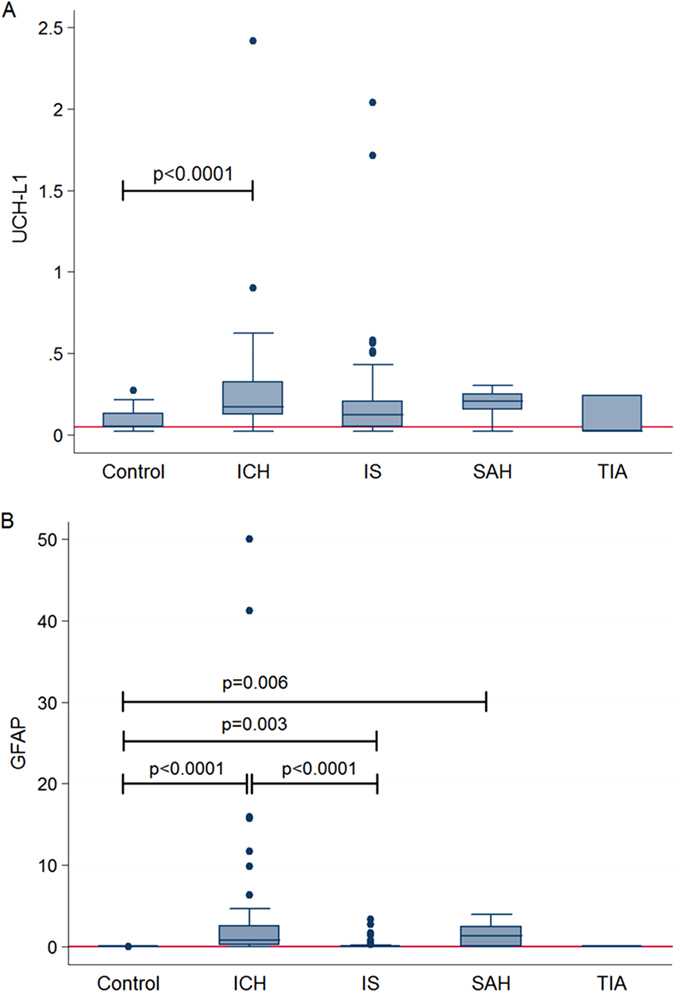
Box-and-whisker plots demonstrating UCH-L1 and GFAP concentrations within 24 hours of symptom onset.Serum UCH-L1 (A) and GFAP concentrations (B) in patients with stroke or TIA and controls. The horizontal line in each box represents the median, with the boxes representing the interquartile range. Significant differences are indicated (Kruskal-Wallis test). The reference line (red line) represents the median of estimated normal values.